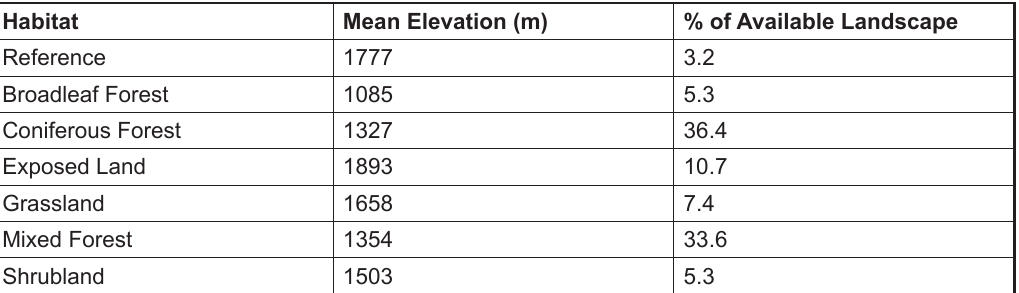
Table 1. Average elevation at each habitat class and the relative composition of each habitat component across the landscape. These habitat classifications were used in logistic regression RSF models fitted to data from resident Columbia North caribou and animals translocated into the population.